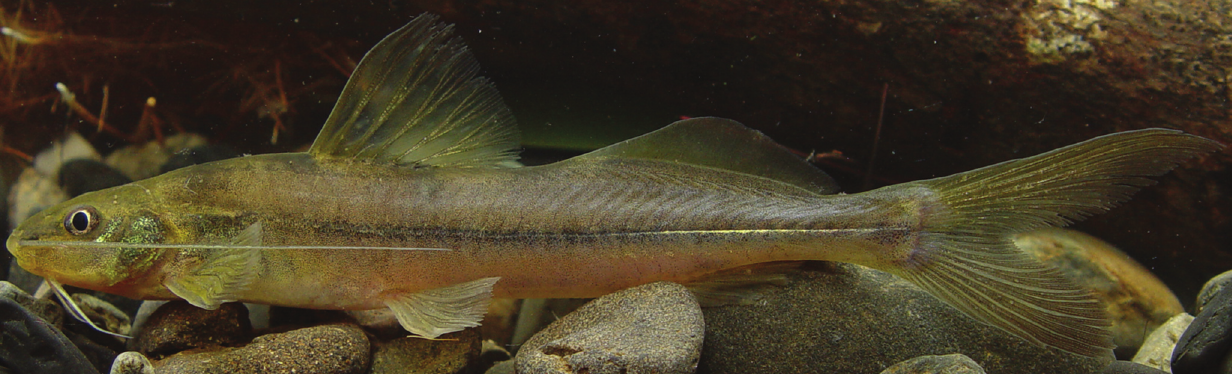
Fig. 4. Imparfinis usmai , live specimen (IMCN 3842, 73.6 mm SL), Colombia, Cauca, Caloto, río Japio, upper río Cauca basin, 03°01’N